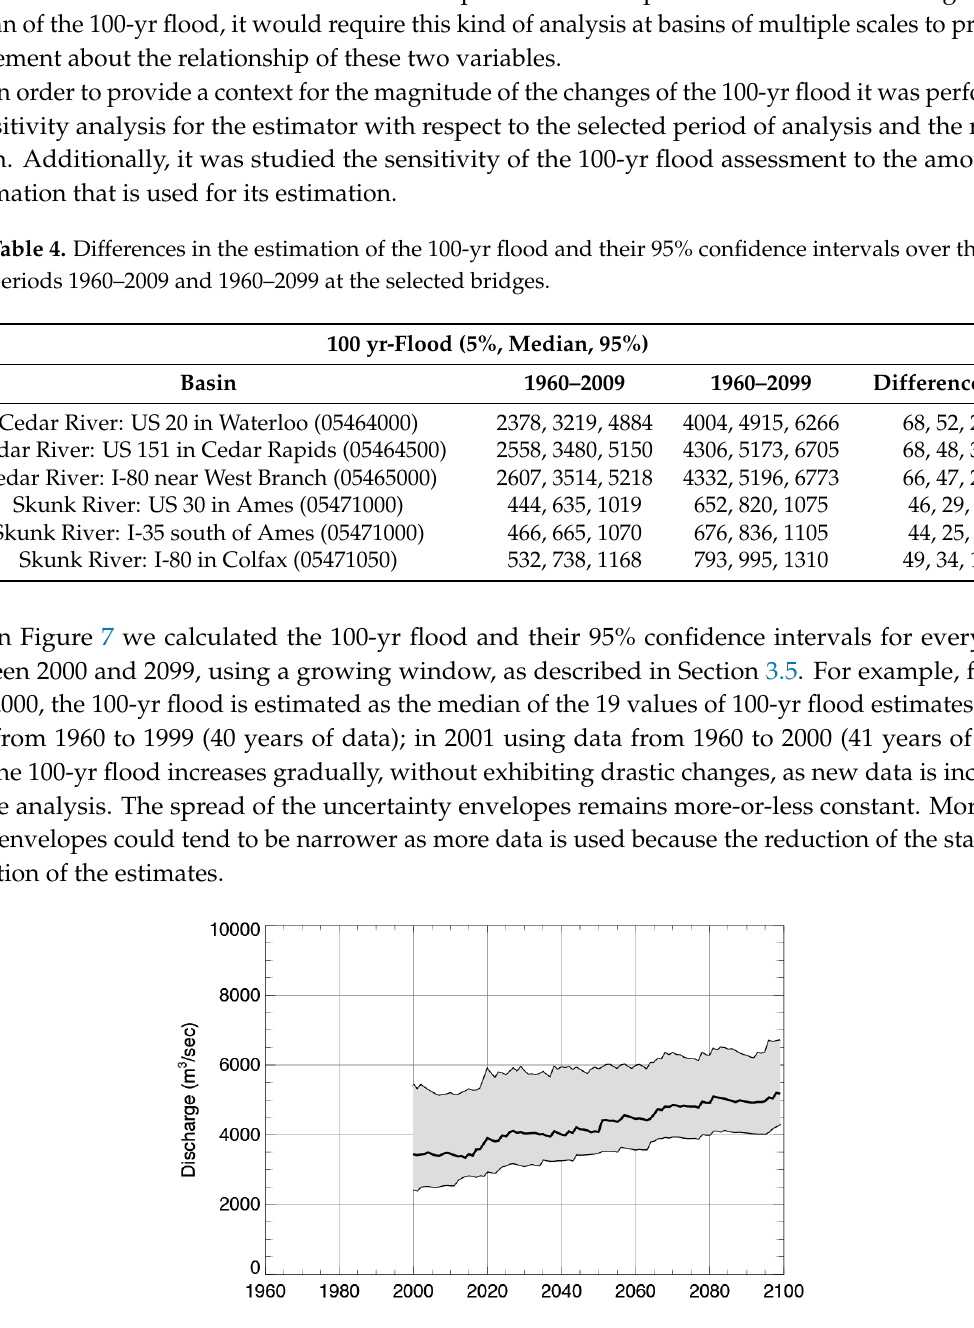
Figure 7. The black solid line is the median of the 19 values of 100-yr flood estimates using the data from a growing time window starting with 40 years in the year 2000 and increments of one year. The shaded area represents the 95% confidence intervals of the